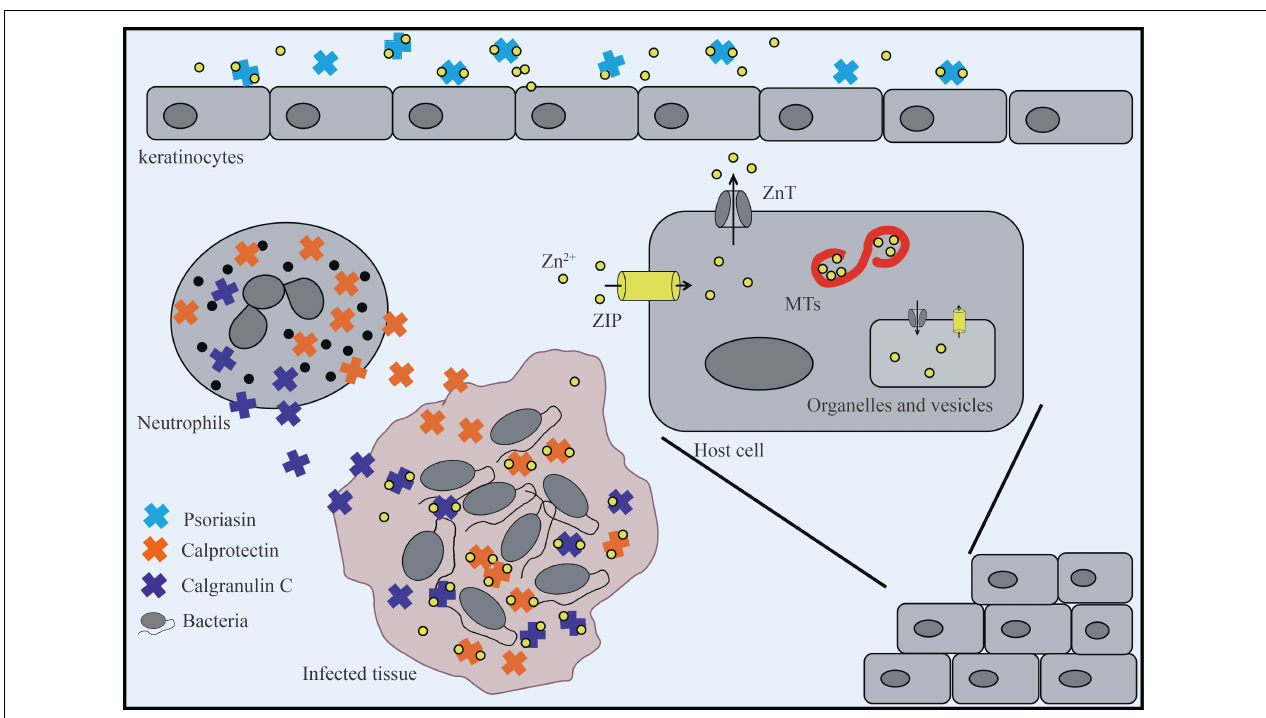
FIGURE 1 | The host limits the absorption of zinc by bacteria. Keratinocytes secrete psoriasin to sequester metals and prevent infection. In the infected tissue, neutrophils that release calprotectin and calgranulin C are recruited, which inhibits bacterial invasion by chelating Zn 2 + . In addition, host cells mobilize Zn 2 + into or out of the cytoplasm through two tissue-specific Zn 2 + transporters: Zrt/Irt-like protein (ZIP) and ZnT. In the cytosol, metallothioneins (MTs) bind Zn 2 + to reserve, buffer, and chelate and enter or leave intracellular organelles and vesicles through ZnT and ZIP